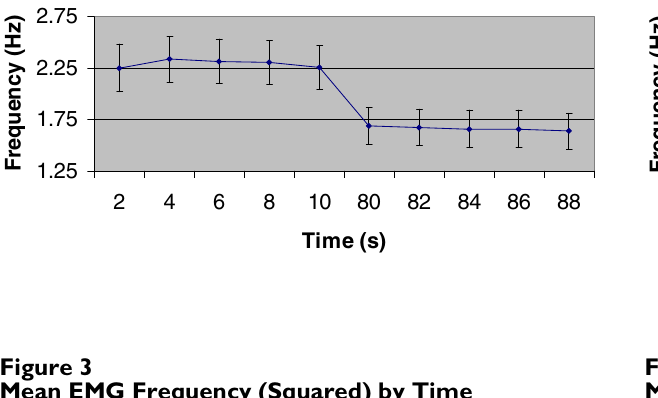
Figure 3 Mean EMG Frequency (Squared) by Time